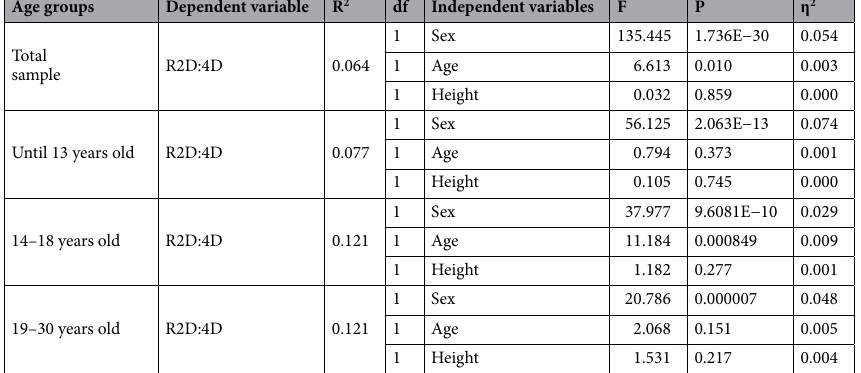
Table 5. The GLM ANCOVA three-factor (sex, age, height) analyses for outcome variables the right 2D:4D ratio in total sample (until 30 years old), and prepubertal, pubertal, and young age cohorts from European population. R 2 R Squared, df degrees of freedom, F F test statistics, p statistical significance, η 2 Partial Eta Squared effect